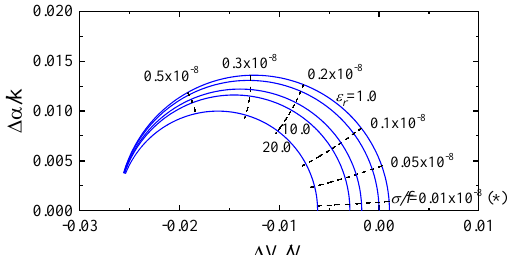
Figure A1. The relative permittivity–conductivity chart derived from Equations (A5) and (A6). (*: 1 × 10 −8 (S/m)/Hz)